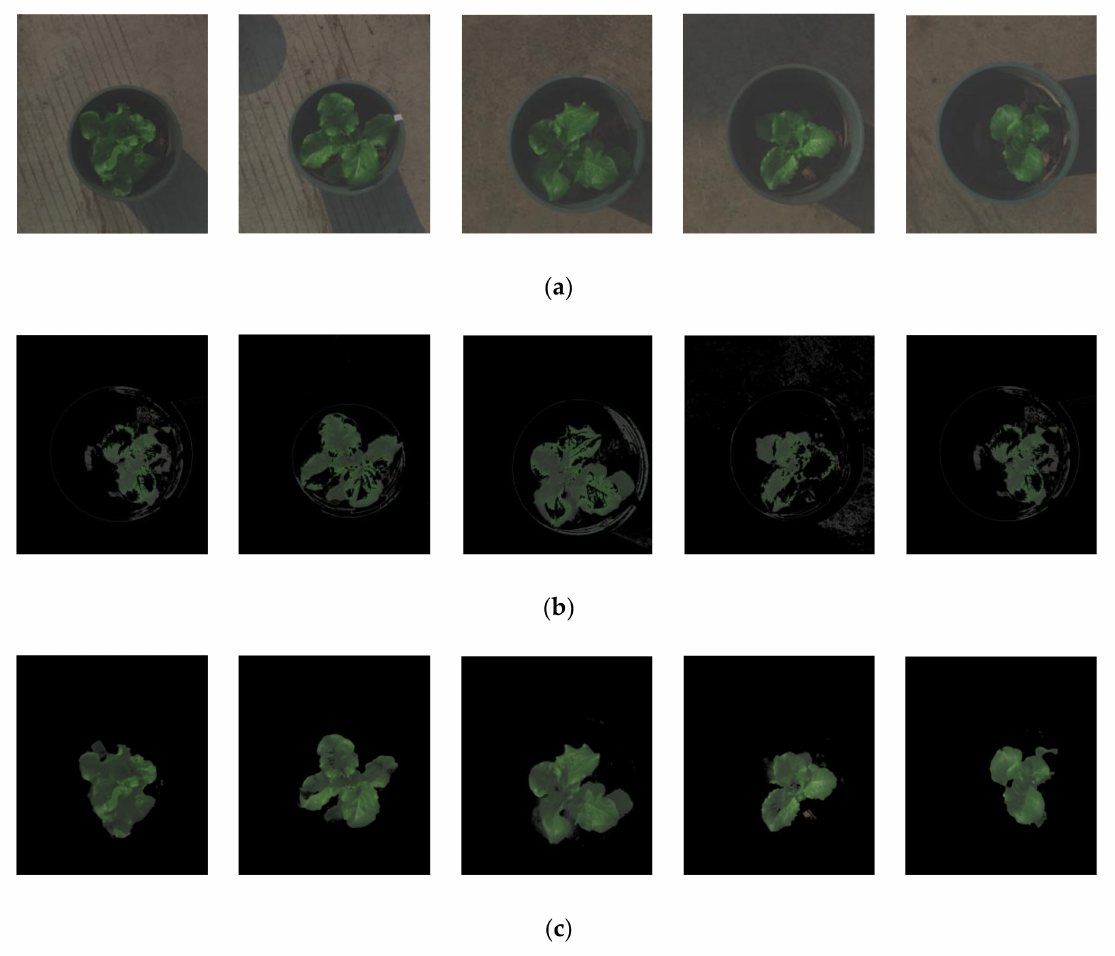
Figure 9. Comparison diagram of sample segmentation results. ( a ) Sample raw RGB image. ( b ) Seg- mentation results of reflectance threshold segmentation method. ( c ) Correlation difference method segmentation